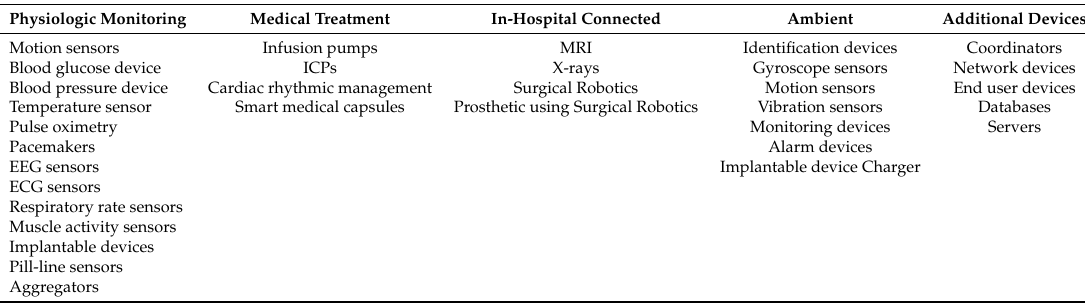
Table 4. A categorisation of the most common IoMT